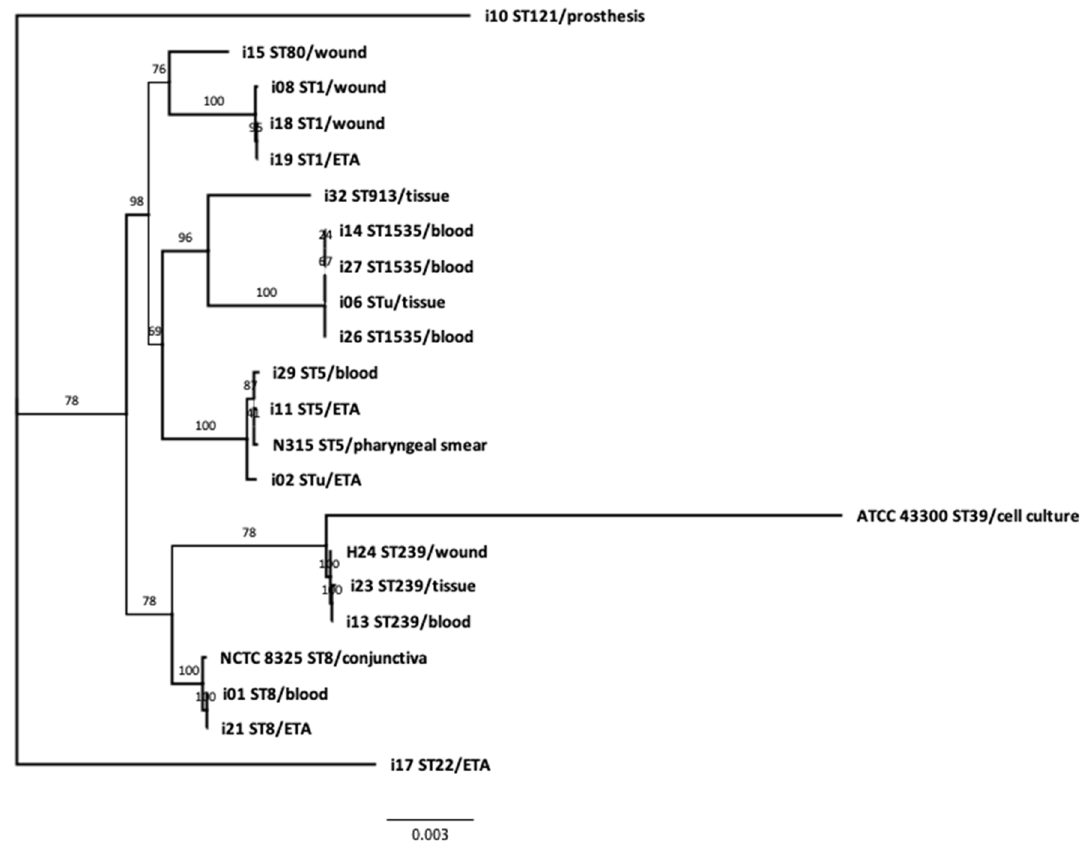
Figure 1. Codon tree-based phylogenetic analysis of MRSA isolates showing genetically linked MRSA clones. Isolate codes and sequence types, as well as source of isolation, are shown. S. aureus ATCC 43300, sequenced as control in this work, as well as NCTC 8325 (ST8) and N315 (ST5), were used as reference isolates. S. aureus H24, being the only fully sequenced isolate with confirmed geographical origin in Egypt (see Discussion), is used for comparison. The phylogenetic tree was built with the PATRIC pipeline, with a set of 1000 conserved core genes.